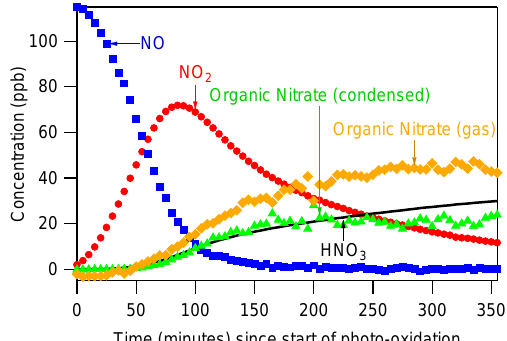
Figure 1. Time series of oxidized-nitrogen species in Exp. 7. NO, NO 2 , and organic nitrate (condensed) are measured directly. HNO 3 is modeled using SAPRC. Organic nitrate (gas) is calculated from a mass